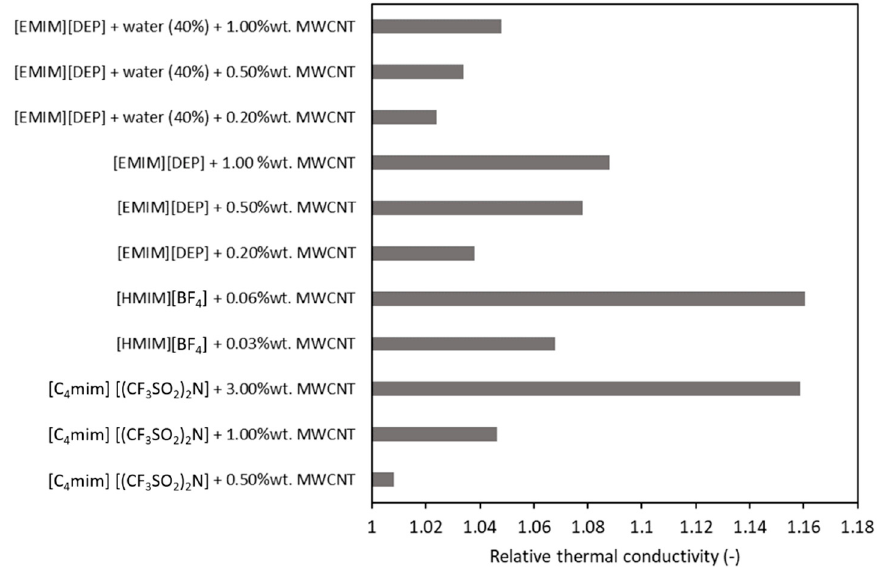
Figure 4. Influence of the base fluid on thermal conductivity of fluids with MWCNTs [26,34,37].